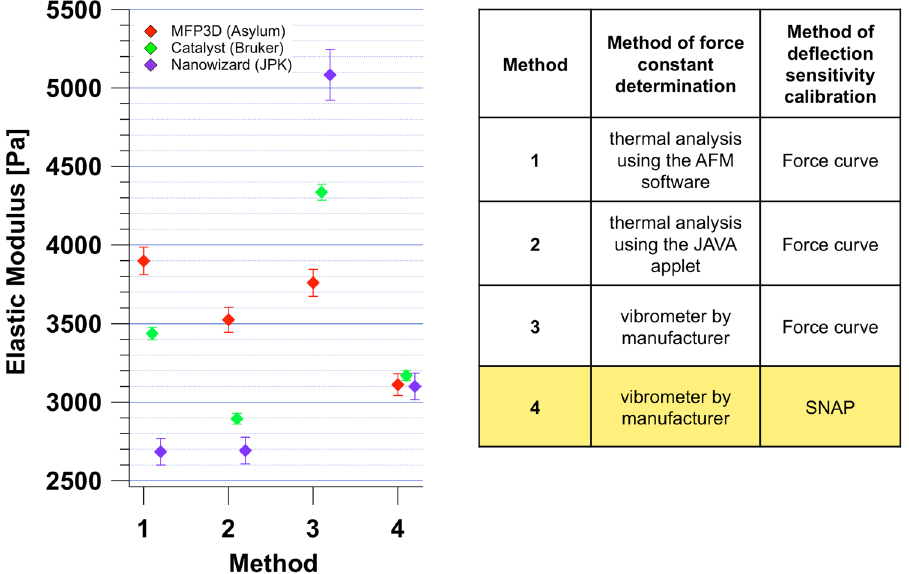
Figure 2. SNAP reduces the variability of mechanical measurements on the same gel in different locations. Elastic moduli of the same gel measured with three different instruments using the same kind of colloidal probes. The data were then analysed with different methods numbered from 1 to 4. In 1 to 3 ones, the deflection sensitivity was calibrated with a force curve on a stiff substrate and the force constant was determined from the analysis of the thermal with the AFM software (1); from the analysis of the thermal with the JAVA applet (2) and from the vibrometer measurements (3). In method 4, SNAP was applied: the force constant was measured using the vibrometer and deflection sensitivity was re-calibrated with the correction factor λ